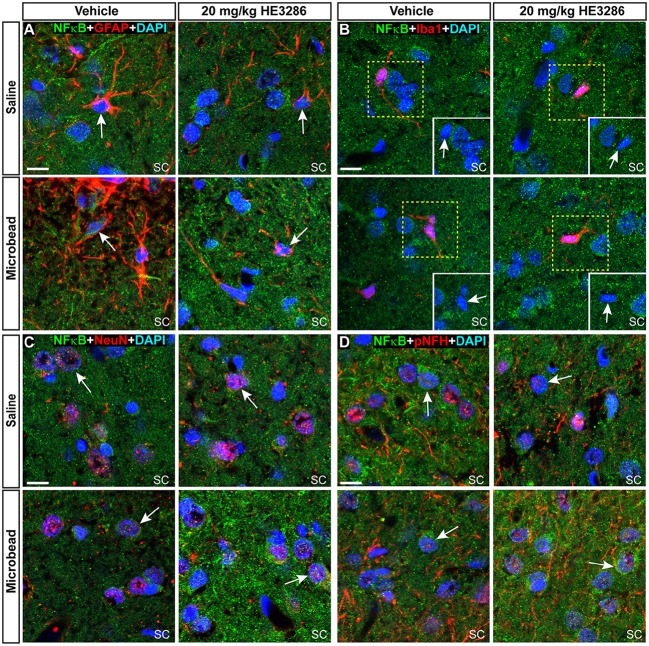
NFκB localizes to both neuronal and glial nuclei in superior colliculus. Representative confocal images of NFκB in the superior colliculus (SC) of vehicle- and HE3286-treated rats with all nuclei indicated (DAPI). Sections were also labeled for astrocytes (A, GFAP), microglia (B, Iba1), or neurons using antibodies against either NeuN (C) or phosphorylated neurofilament heavy (pNFH; D). Representative nuclei from each cell class demonstrated NFκB localization (arrows). Insets (solid white, B) show region contained within dashed box with red channel removed to better visualize nuclear localization of NFκB. Scale: 10 μm.